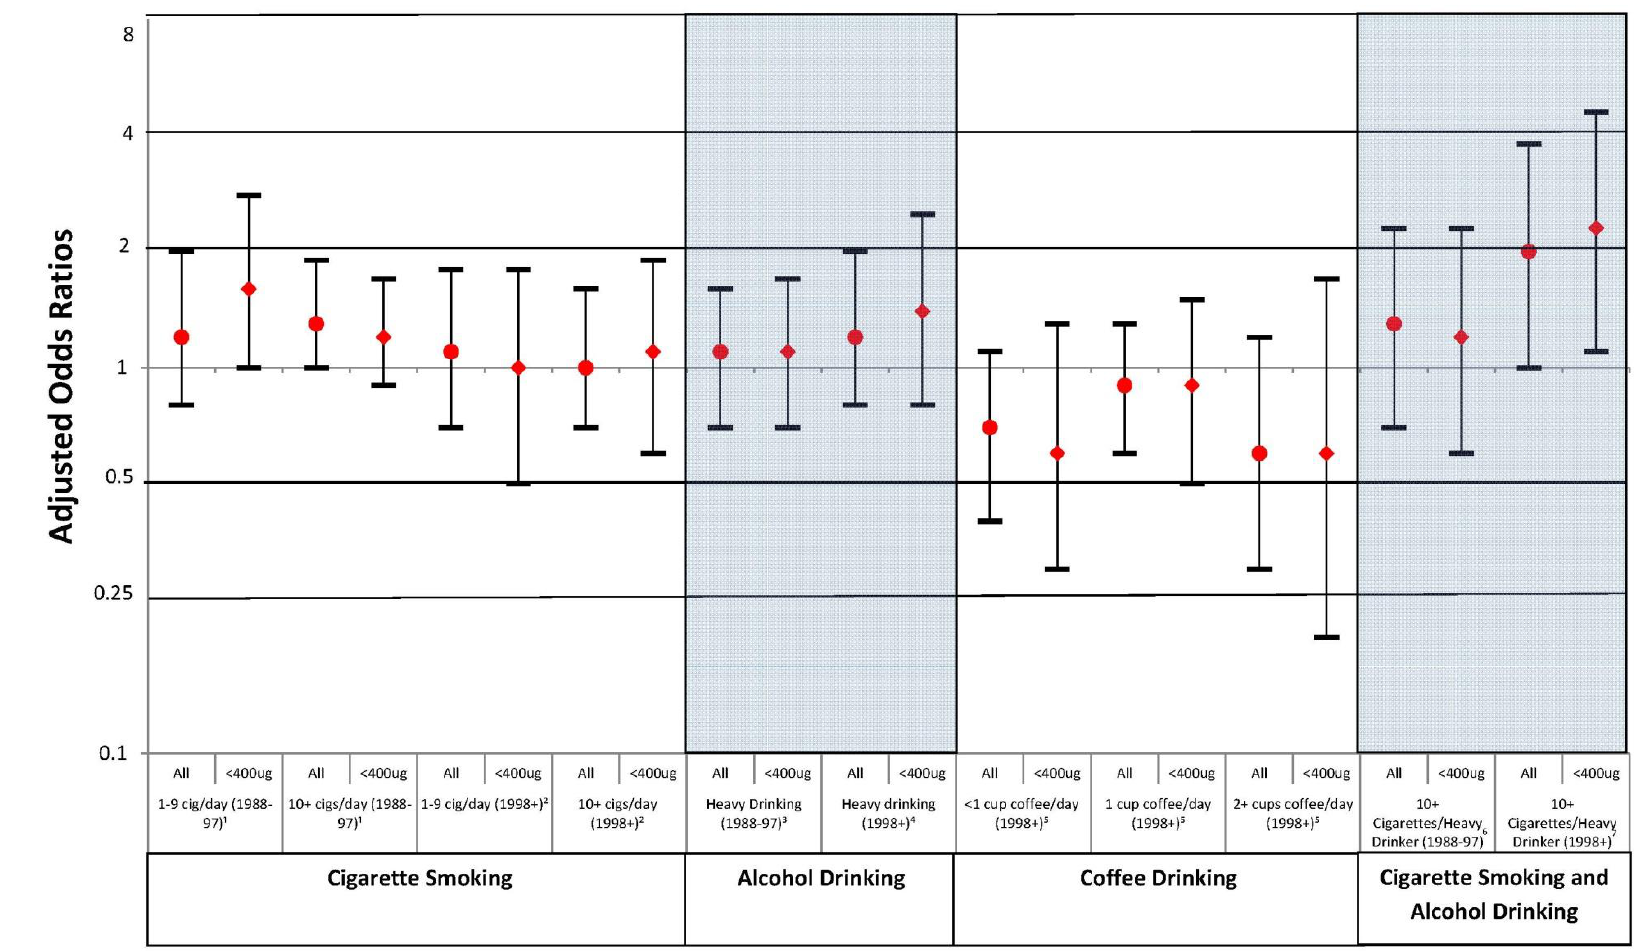
Figure 1. Adjusted Odds Ratios for Associations between Spina Bifida and Exposure for All Subjects and Subjects with <400μg Daily Folic Acid intake, Birth Defects Study